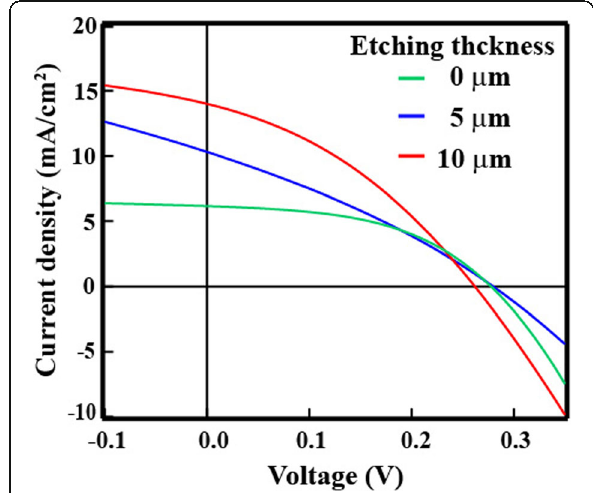
Fig. 7 a I – V characteristics of SiNW solar cells with Al 2 O 3 removed by